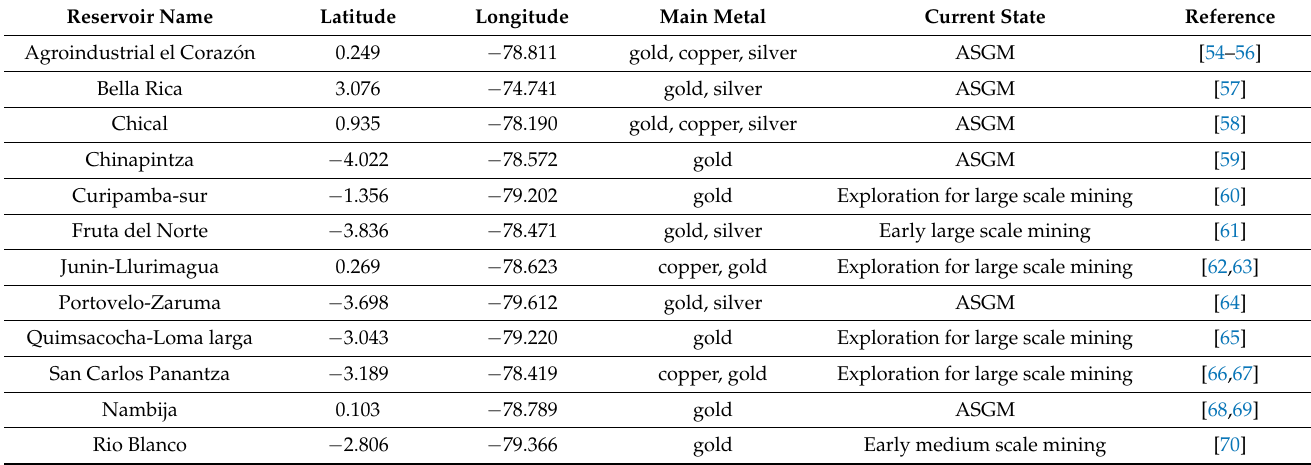
Table 1. Sources of information for the different metallic reservoirs and location coordinates